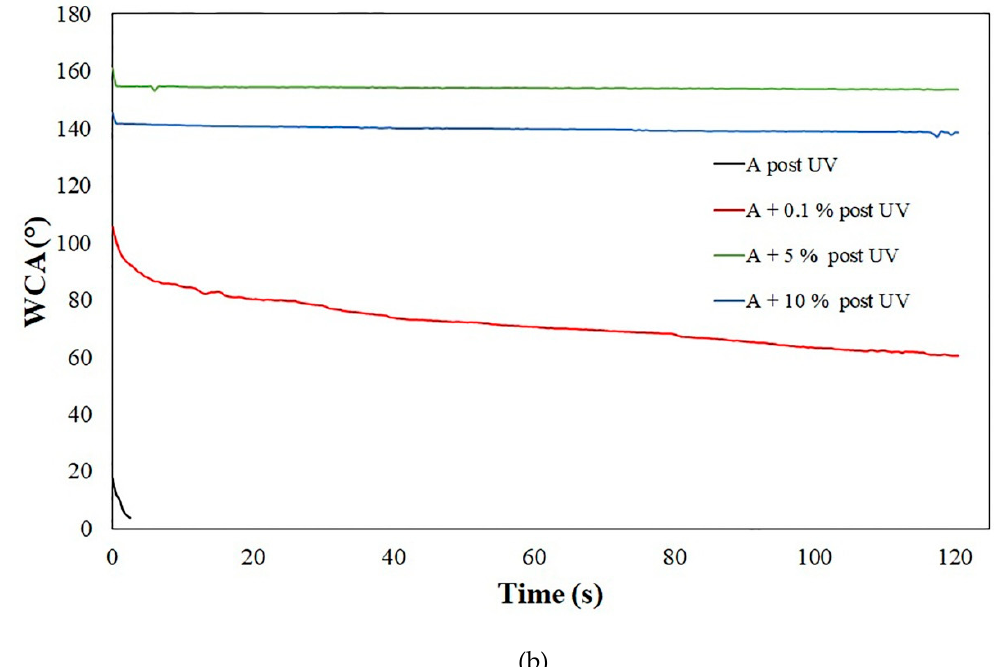
Figure 1. The water contact angle (WCA) during time on untreated alder samples (A), before ( a ) and after UV exposure ( b ).